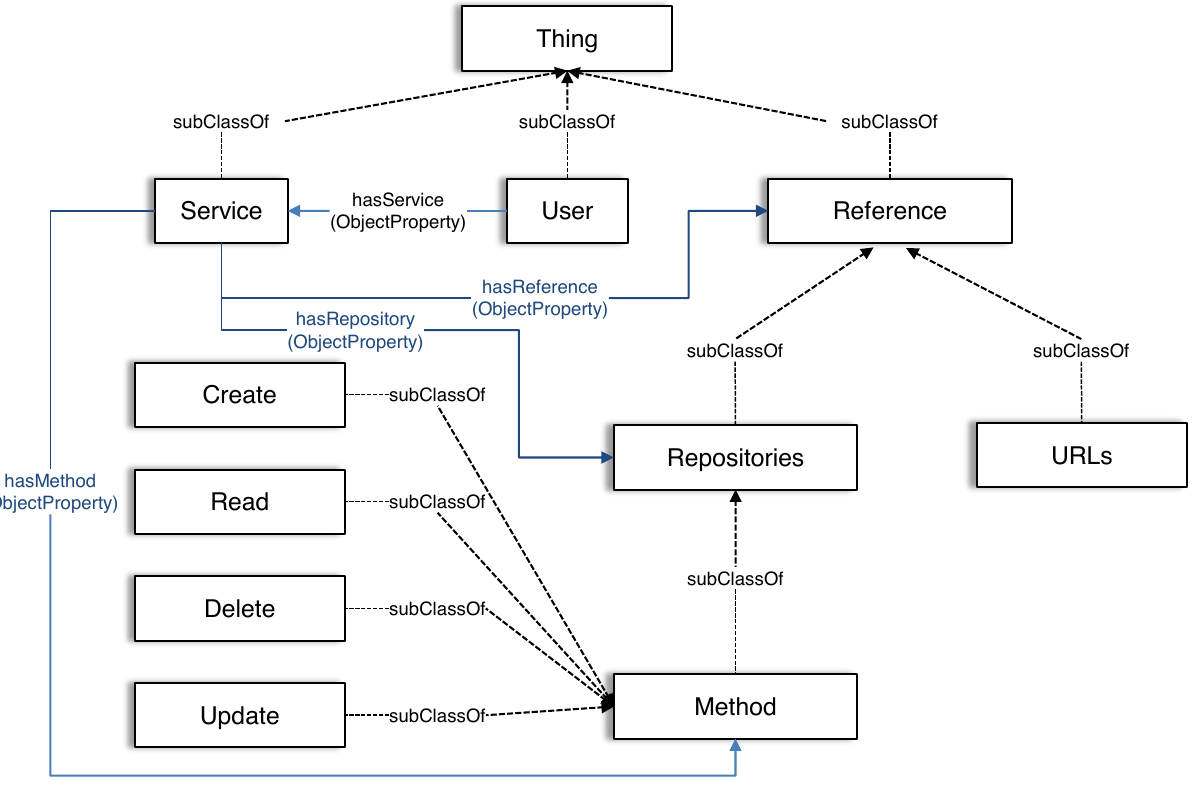
Figure 2. A schema of the IoT-based service integration ontology (IIO) to support ontologies created from various IoT-based service domains. The rectangle represents classes. The solid line represents a relationship between individuals, and the dashed line represents a relationship between super-class and